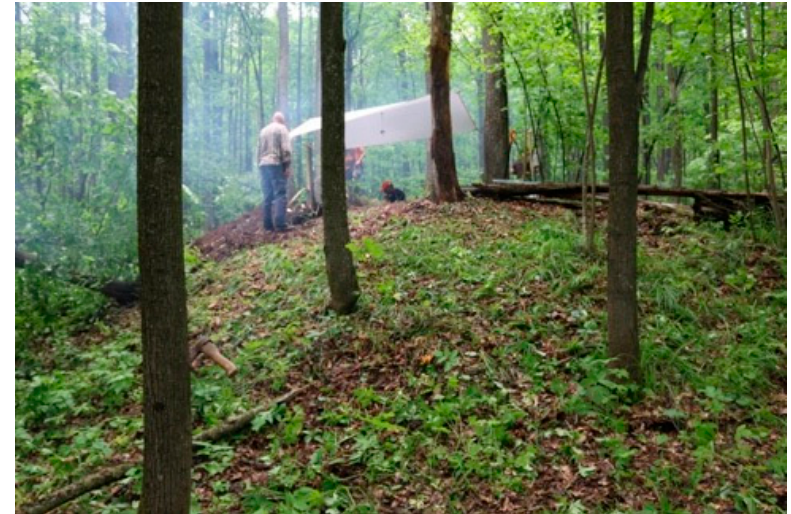
Figure 2. General view on the burial mound and the broadleaf forest vegetation of the study